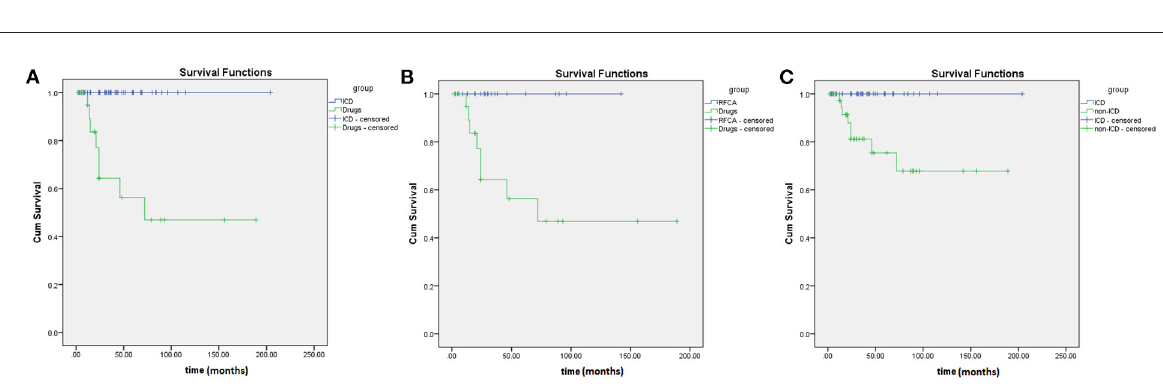
FIGURE4 Comparison of Kaplan-Meier survival curves in short-coupled variant of torsade de pointes (scTdP) patients with different treatments. (A) implantable cardioverter defibrillator (ICD) vs. medication ( P < 0.001); (B) radiofrequency catheter ablation (RFCA) vs. medication ( P = 0.006); (C) ICD vs. non-ICD ( P =